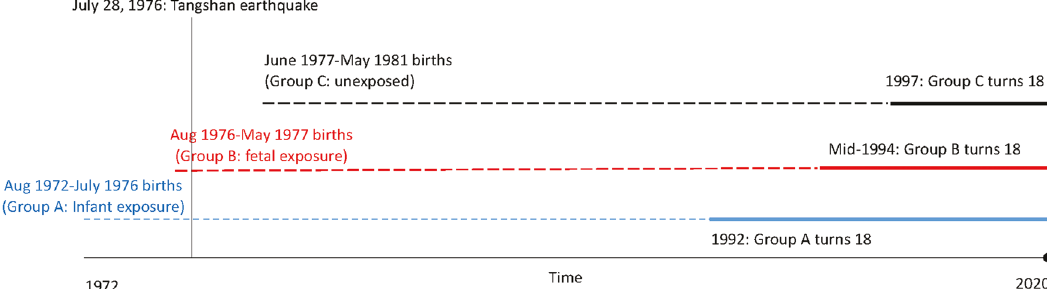
Fig. 1 Timeline of cohort births by exposure to the Tangshan earthquake. Dashed lines represent the period in which cohort members could not be diagnosed with schizophrenia. Solid lines represent the follow-up time in which cohort members could be diagnosed with schizophrenia.